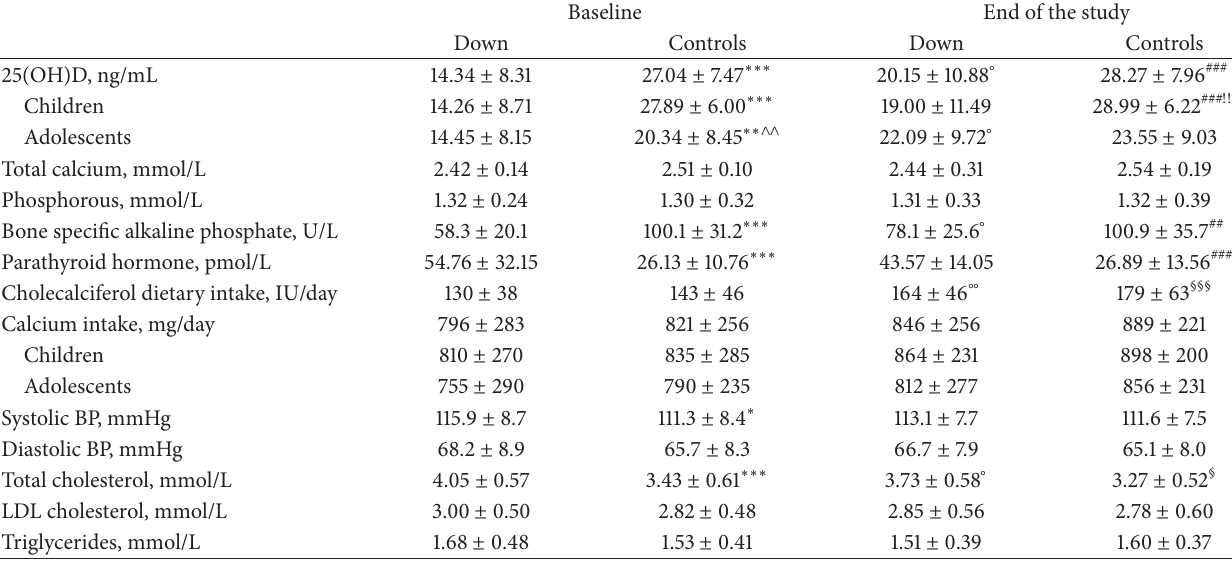
Table 1: Biochemical and demographic parameters in Down syndrome and healthy controls at baseline and at the end of the intervention. Baseline End of the study Down Controls